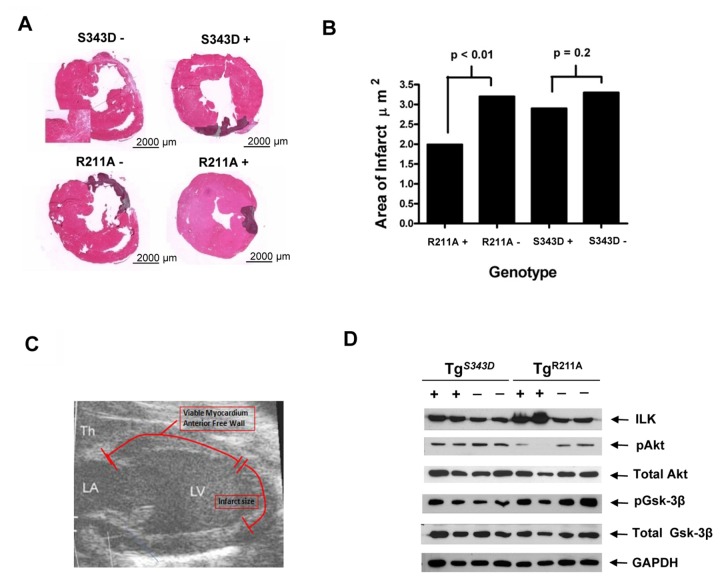
ILKR211A Improves Post-Infarct Remodeling.
A, H & E staining of axial sections 28 days post LAD ligation in transgenic (Tg) mice with cardiac-specific over-expression of constitutively-active (S343D+) or R211A+ mutation and littermate controls (S343D- and R211A-). Scale bar, 200 µm (high magnification), 2000 µm (low magnification). B, Planimetric calculations indicate a significant reduction in infarct size in R211A genotype, p(ANOVA) <0.01, and a similar trend in the S343D genotype. C, Echocardiographic measurements show a reduction in infarct size and reciprocal increase in region of viable myocardium in favor of R211A (p=0.04; p=0.001, respectively) and S343D (p=0.12; p=0.05) genotypes as compared to their littermate controls. Detailed measurements are provided in Tables S1 and S2, Online Supplement. D, Western blot showing the protein levels of phosphorylated Akt (pAkt) and Gsk-3β and total amounts of Akt and Gsk-3β in post-MI border zone myocardial lysates derived from two TgS343D and two TgR211A mice (+) and their littermate controls (-). GAPDH was used as a loading control.